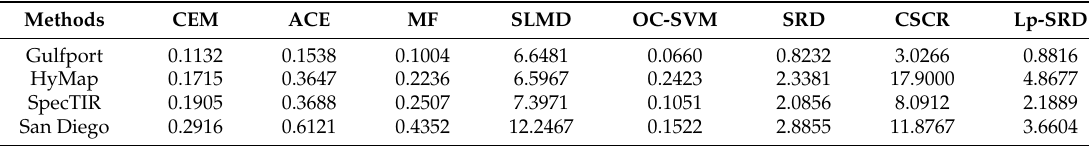
Table 2. Execution time of different target detectors using four experimental datasets (unit: